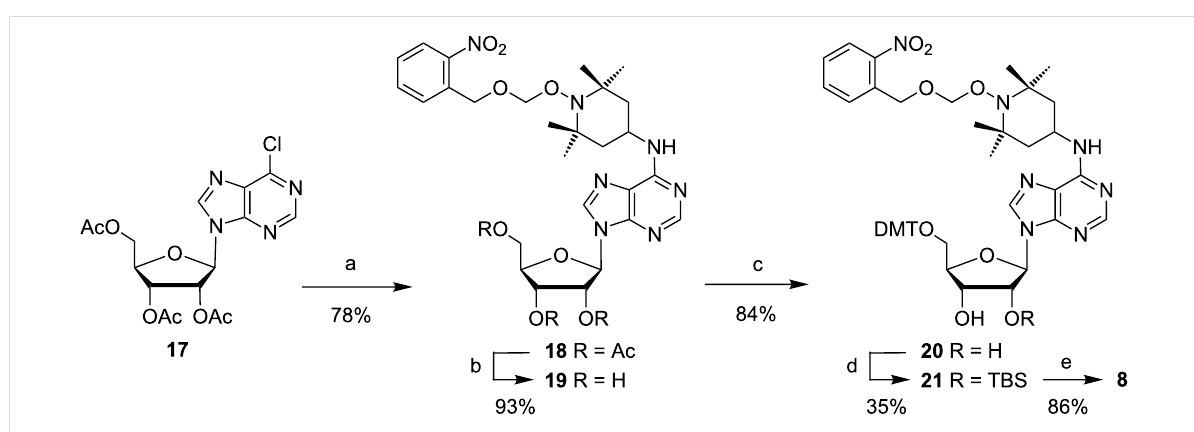
Scheme 3: Synthesis of phosphoramidite 8 . Reagents and conditions: (a) Addition of 10 , diisopropylethylamine, 1-propanol, 75 °C, 7 h, rt, 14 h; (b) 7 N NH 3 in MeOH, 0 °C → rt, 3 h; (c) dimethoxytrityl chloride, pyridine, rt, 20 h; (d) tert- butyldimethylsilyl chloride, imidazole, DMF, rt, 22 h; (e) N , N -diisopropylamino(2-cyanoethyl)phosphoramidic chloride, Et 3 N, CH 2 Cl 2 , rt, 23